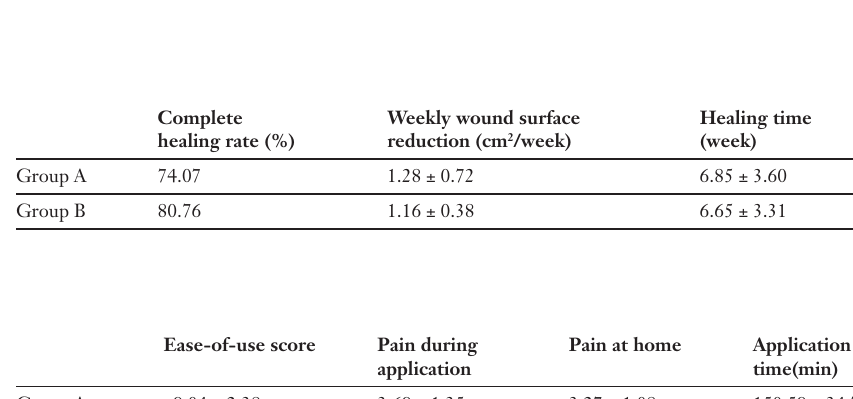
Overall performance, pain during applica- tion and at home, and time spent on application.